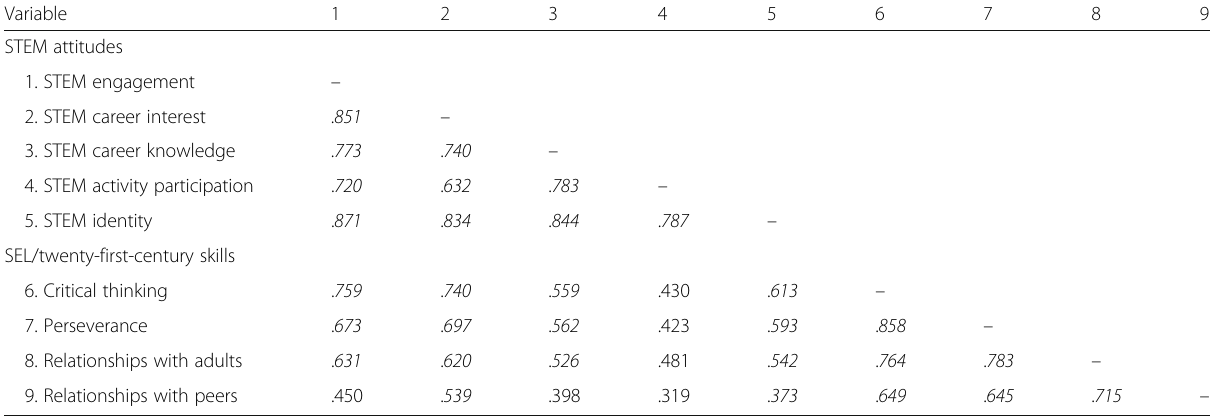
Table 6 Correlations between STEM attitudes and SEL/twenty-first-century skills reported on CIS-S Variable 1